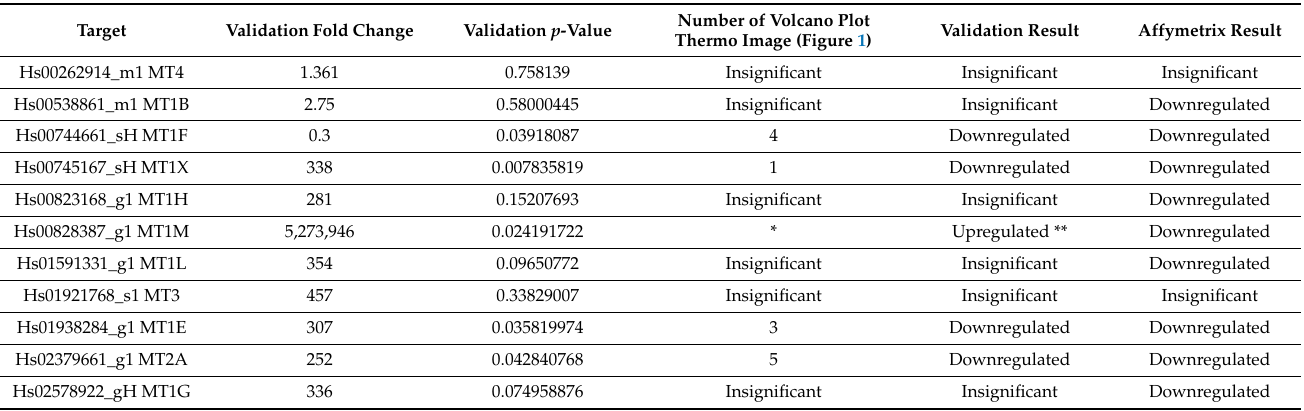
Table 4. Comparison of the results obtained from the gene validation analysis and the first results obtained on Affymetrix Microarrays (statistical analysis using the t -test; fold change boundary: 2.0; p -value boundary: 0.05).